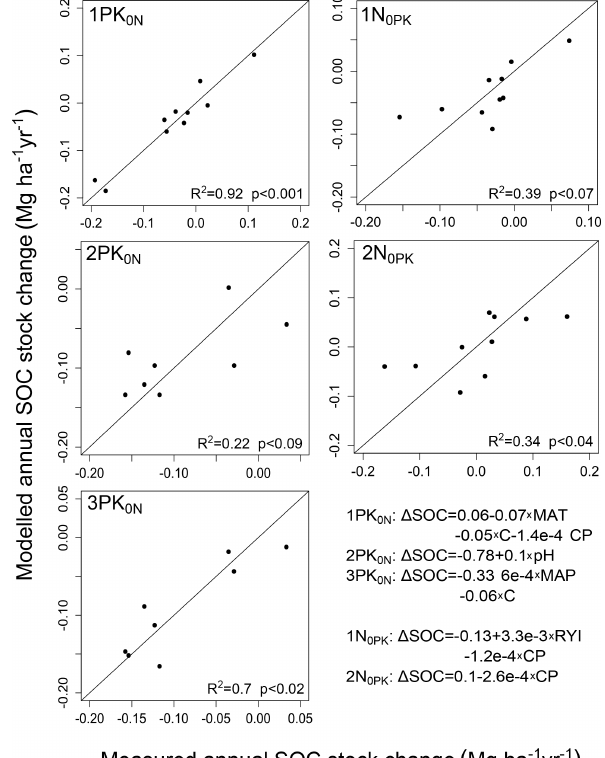
Figure 3. Comparison of measured and modelled annual soil organic carbon (SOC) stock change (Mgha − 1 yr − 1 ) for all phosphorus–potassium (PK) levels and two N levels, with model equations in which MAT is mean annual temperature ( ◦ C), MAP mean annual precipitation (mm), pH average initial soil pH, C average initial SOC concentration (%), CP the average initial C:P available ratio and RYI the relative yield increase